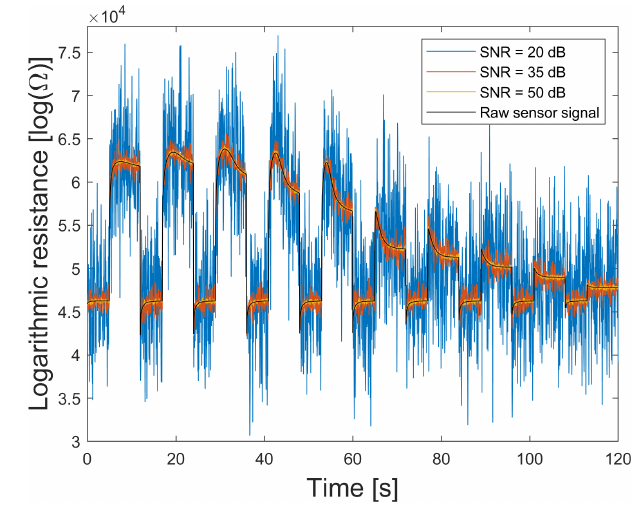
Figure 4. Raw (violet) and modified sensor signals with additive white Gaussian noise of different SNR values.